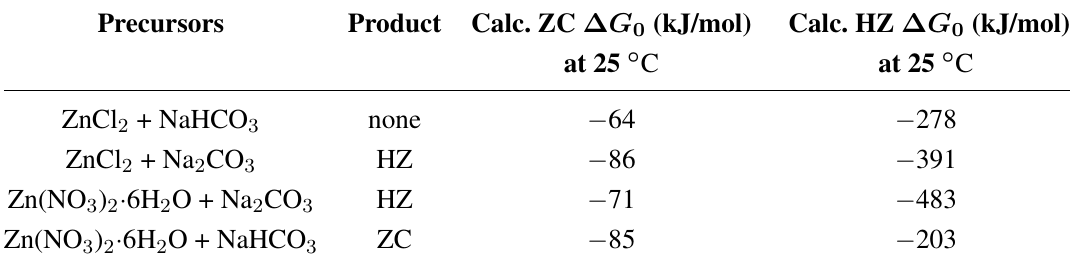
Table 1. Products from ambient SSM using different precursor combinations. Here,